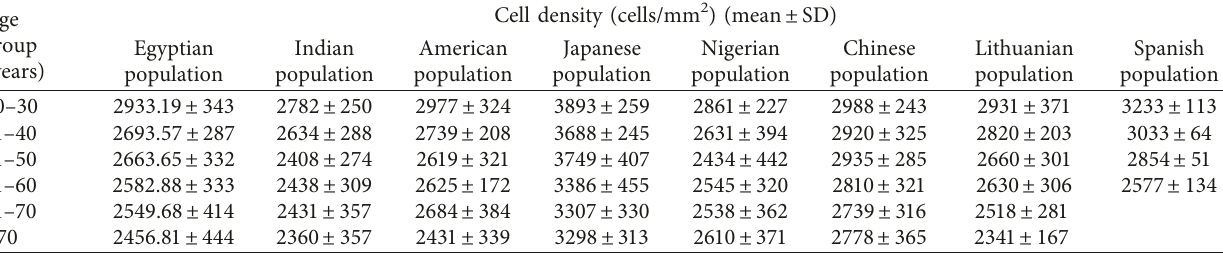
Table 6: Comparison of the mean corneal endothelial cell density according to age among healthy Egyptian, Indian, American, Japanese, Nigerian, Chinese, Lithuanian, and Spanish